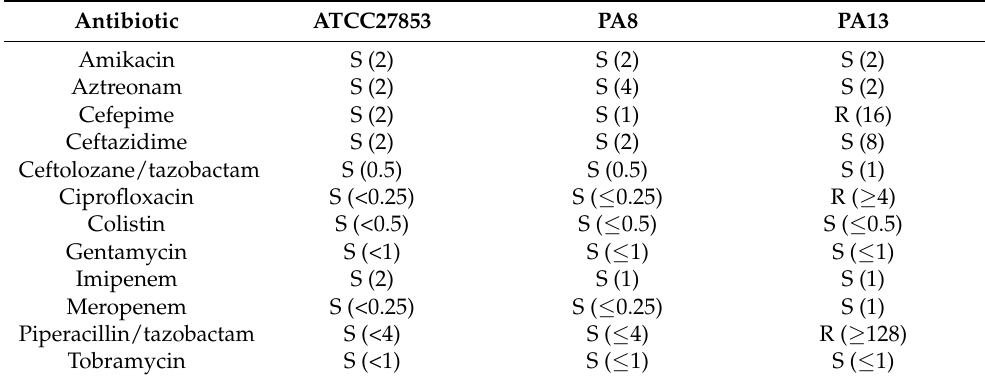
Table 5. Antibiotic susceptibility pattern of the three P. aeruginosa studied in this work. Data are given in mg/L. S: susceptible; R: